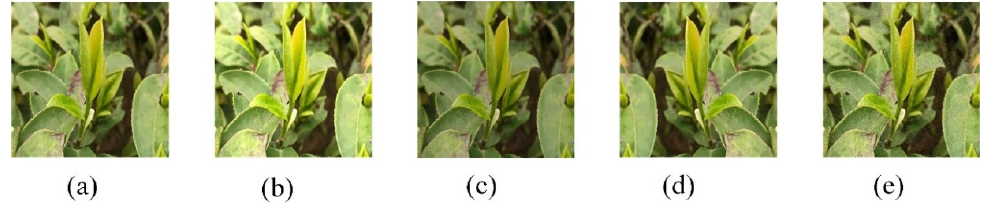
Figure 1. Selected samples of data enhancement. ( a ) Original image; ( b ) enhanced brightness; ( c ) reduced brightness; ( d ) horizontal flip; ( e ) noise addition.